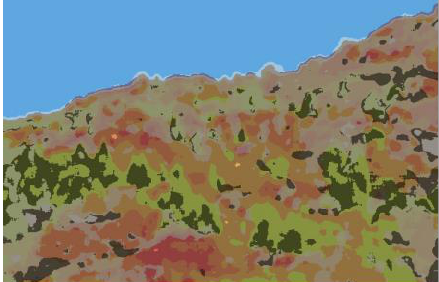
Figure A4. The automatic interpreted color patches in photographs.